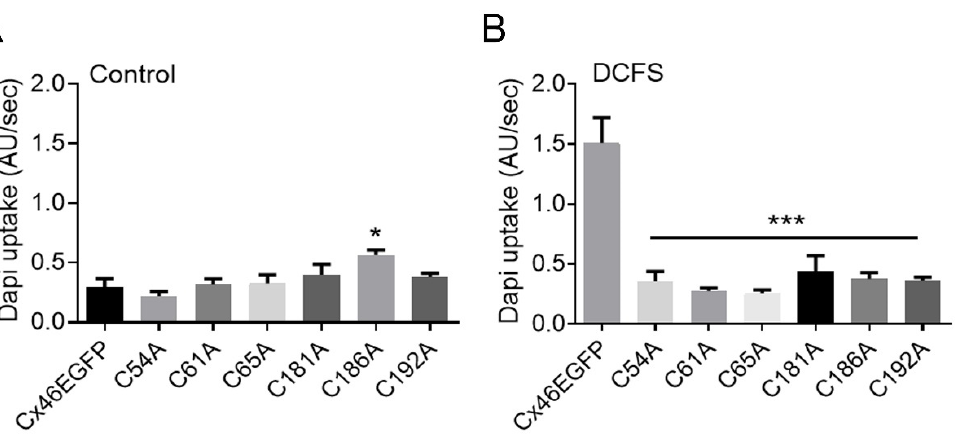
Figure 2. Hemichannels formed by Cys mutants do not open upon exposure to divalent cation free solution (DCFS). HeLa cells transfected with wild-type Cx46 or Cys mutants were placed in recording media containing 10 µ M DAPI under control conditions or in DCFS. Pictures of 16 cells were taken every 20 s for 20 min, with 4 replicates. DAPI uptake was calculated as arbitrary units per second (AU/Sec). ( A ) Control conditions. The rate of DAPI uptake was similar in cells expressing all Cys mutants, except for the C186A mutant, which showed a small, but significant higher, DAPI uptake compared to cells expressing wild-type Cx46 (*, p < 0.05). ( B ) DCFS. HeLa cells expressing wild-type Cx46 showed an enhanced rate of DAPI uptake, which was not observed in any of the Cys mutants (***, p < 0.001) ( n = 4 for each condition).